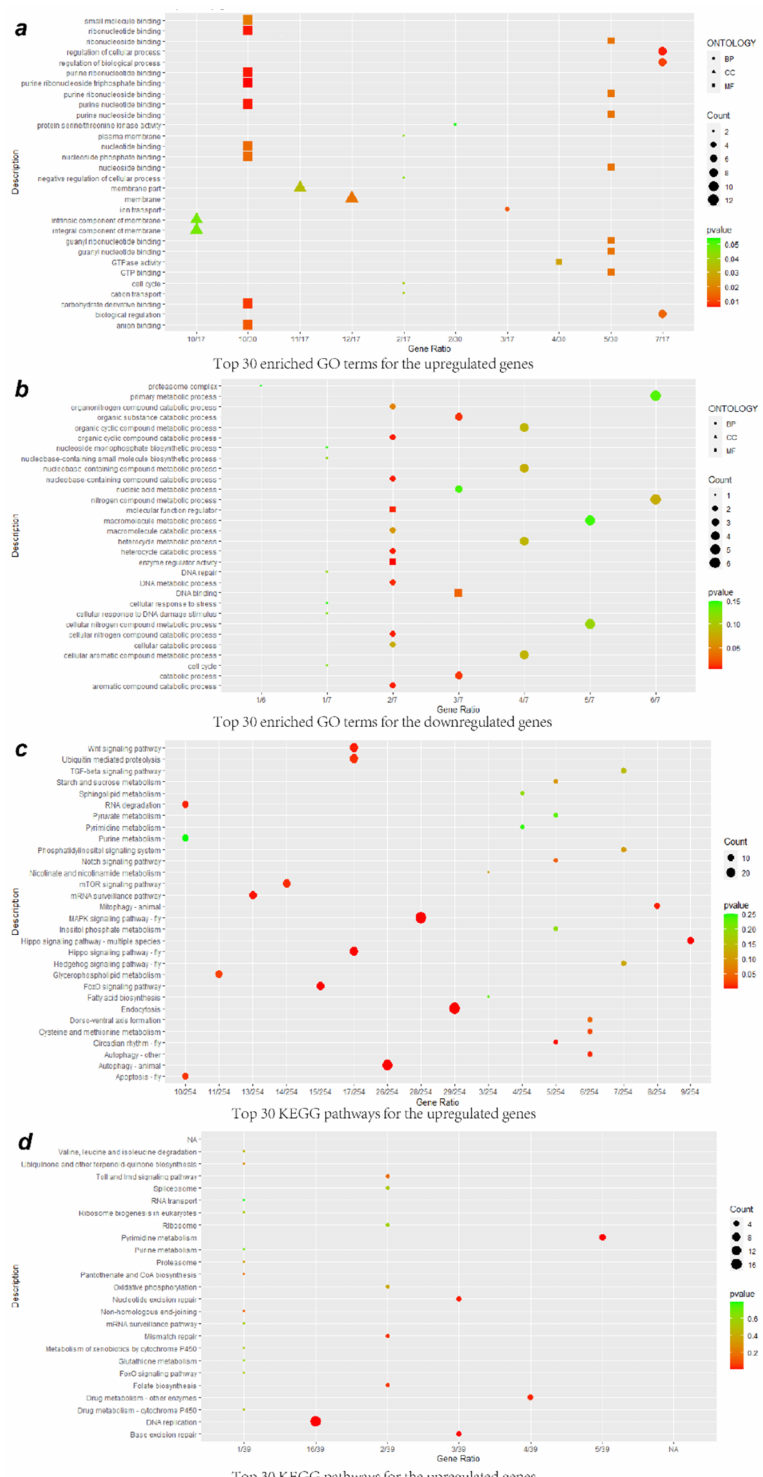
Figure 3. Bubble plots comparing GO enrichment and KEGG pathway analysis. ( a ) The 30 most significantly enriched GO terms for upregulated DEGs. ( b ) The 30 most significantly enriched GO terms for downregulated DEGs. ( c ) The 30 most significantly enriched KEGG pathways for upregulated DEGs. ( d ) The 30 most significantly enriched KEGG pathways for downregulated DEGs. The size of the bubble represents the number of enriched DEGs. The color represents the p -value of the enrichment. The shape of the bubble represents the ontology; circles represent BP, triangles represent CC, and squares represent